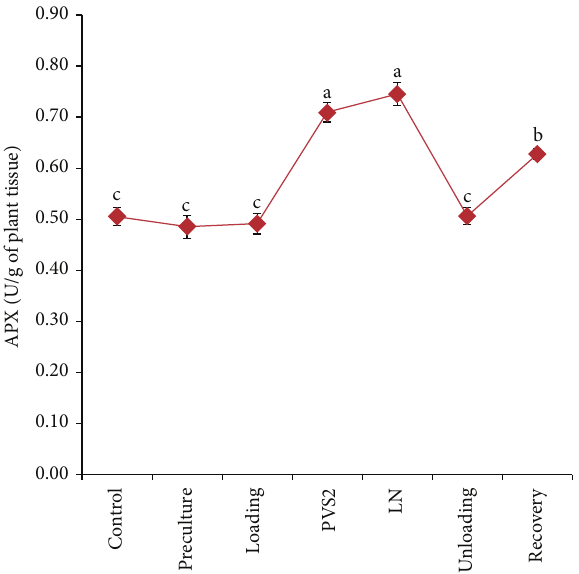
Figure6:Changesinascorbateperoxidase(APX)enzymeactivityat various stages of the cryopreservation. Results were analysed using one-way ANOVA. Means followed by the same alphabet were not significantly different using Tukey test.